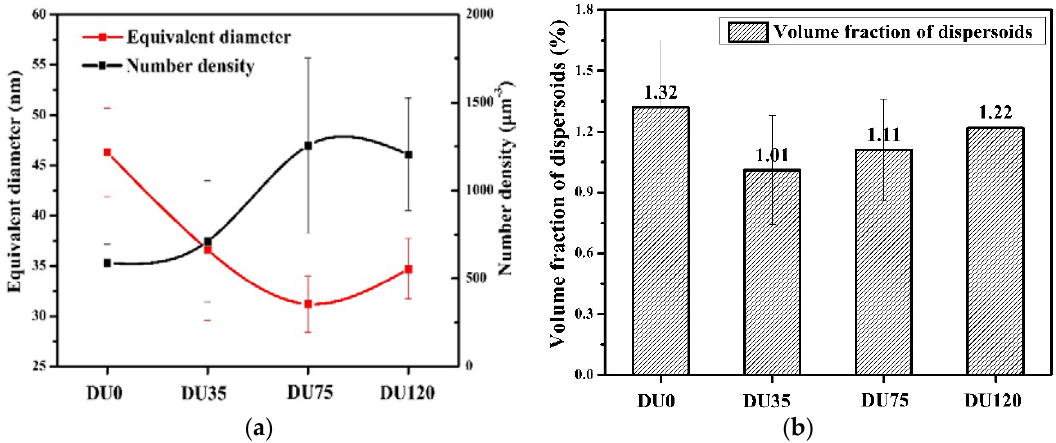
Figure 6. TEM (transmission electron microscope) bright field images of dispersoids after heat-treated at 425 °C for 6 h ( a ) DU0 alloy (0% Cu); ( b ) DU35 alloy (0.37% Cu); ( c ) DU75 alloy (0.72% Cu) and ( d ) DU120 alloy (1.23% Cu).